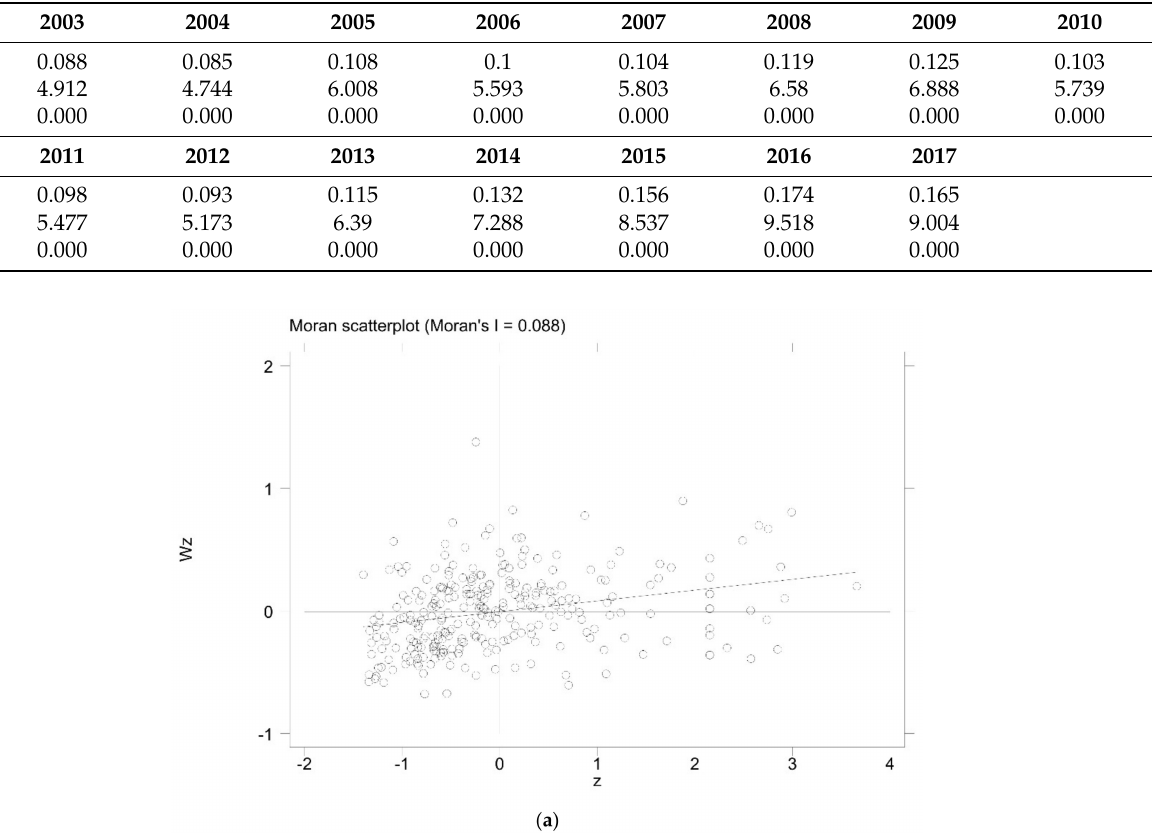
Table 2. Global Moran’s I of city-level CE from 2003 to 2017.